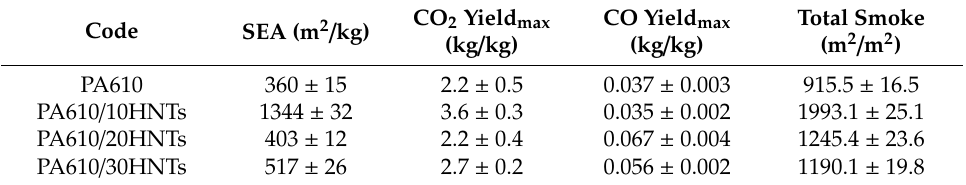
Table 3. Summary of smoke parameters obtained with the CCT on the PA610 and HNT